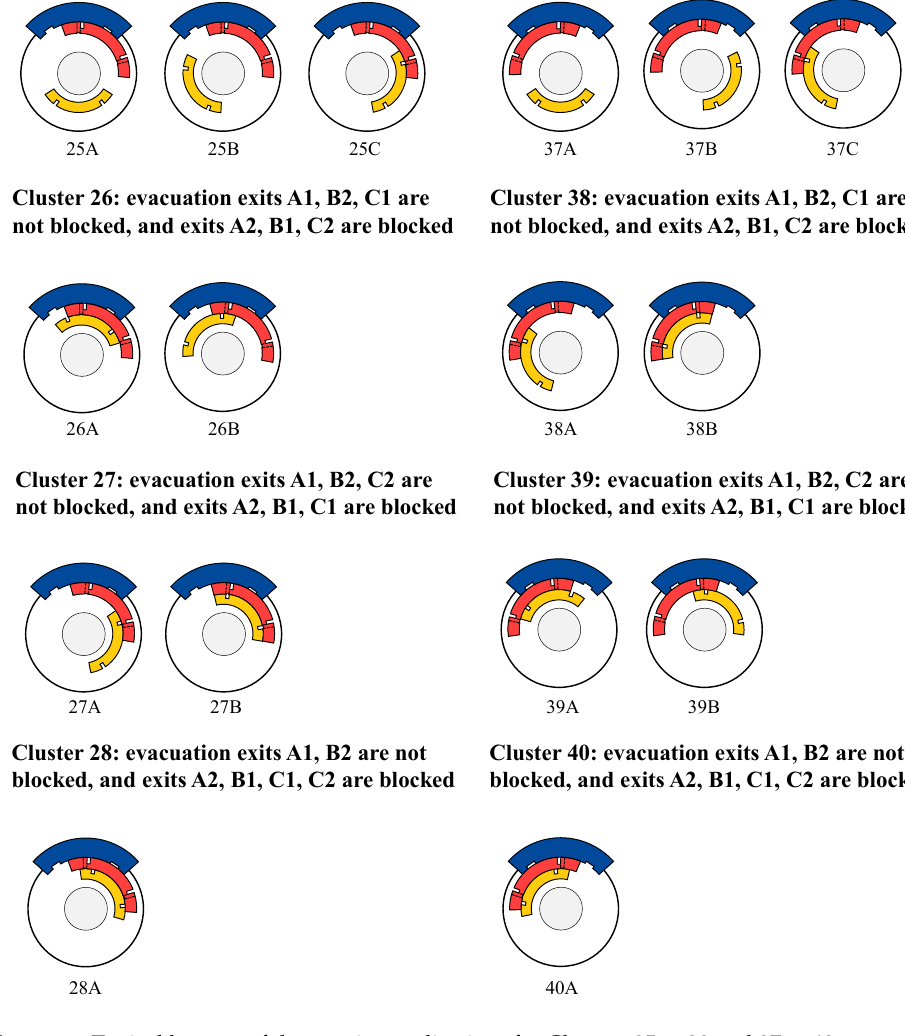
Figure 10. Typical layouts of the rotating auditorium for Clusters 25 to 28 and 37 to 40.